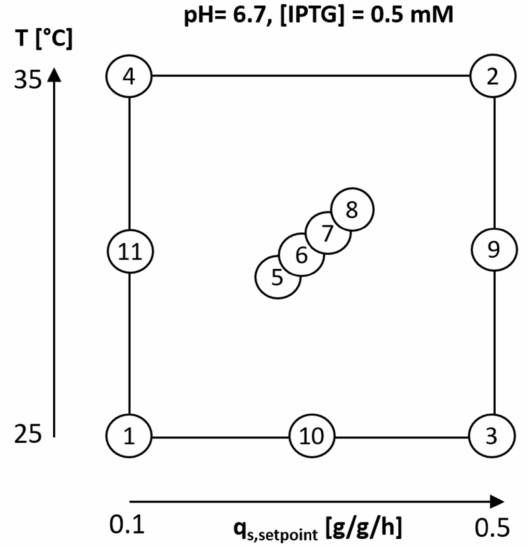
Figure 6. DoE for process optimization to produce active recombinant hyaluronidase IBs. Experiments 1–7 were performed in a modified CCF design. Additional experiments 9–11 were subsequently performed to analyze for quadratic interactions in the region of